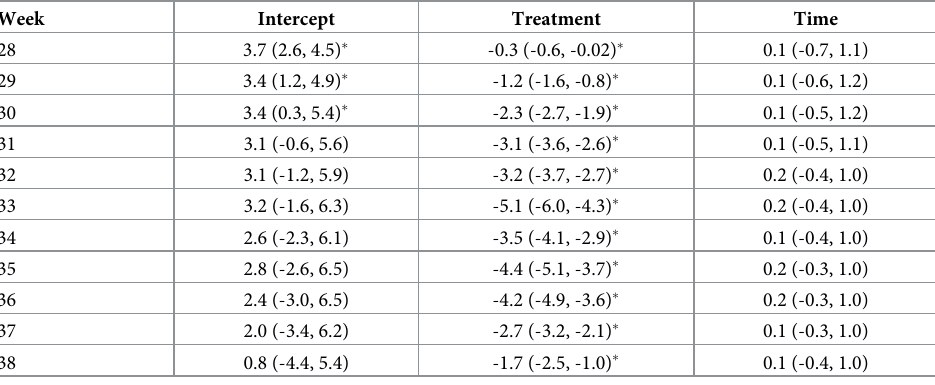
� value is statistically different from zero with a 95% probability; the expected value is the 50 th percentile of the parameter’s posterior distribution, the CIs were drawn using the 2.5 th and 97.5 th percentiles of the parameter’s posterior